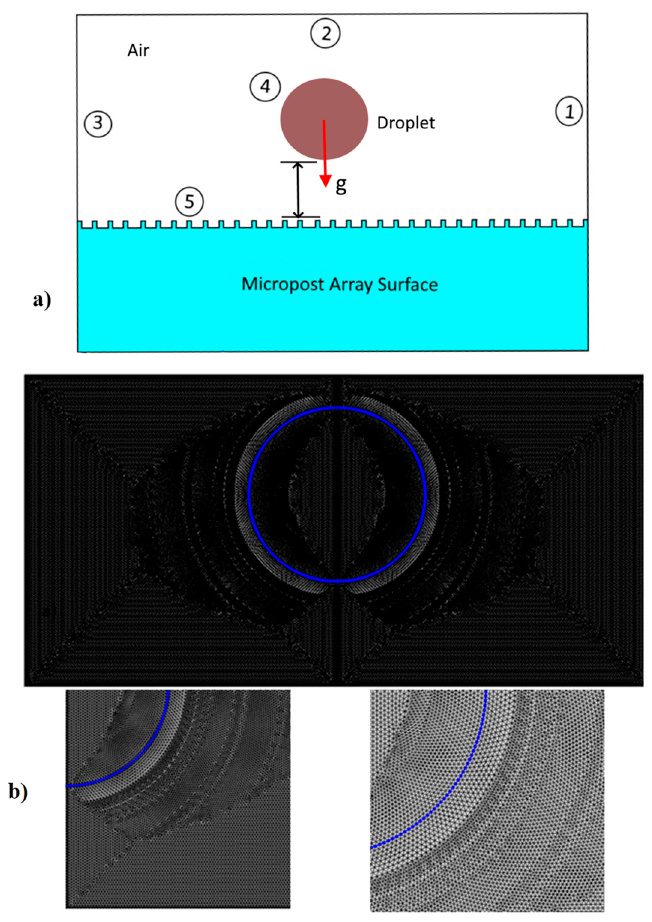
Figure 3. ( a ) Boundary conditions for impacting droplet over hydrophobized replicated micro-post array surface. ( b ) Grid used in the simulations and mesh distribution.